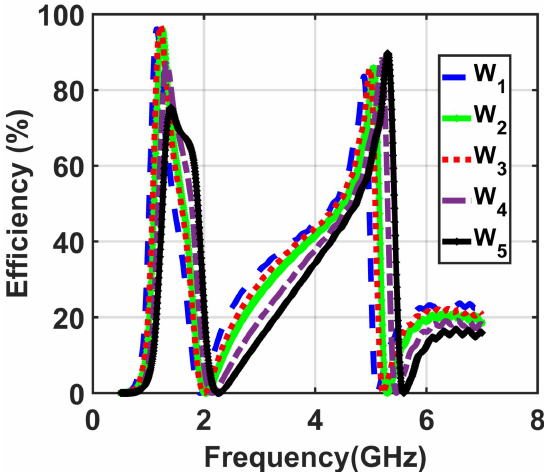
Figure 6. Obtained results of the efficiency of the five investigated cases for the values of the width from W 1 = 1.5 mm to W 5 = 3.5 mm.